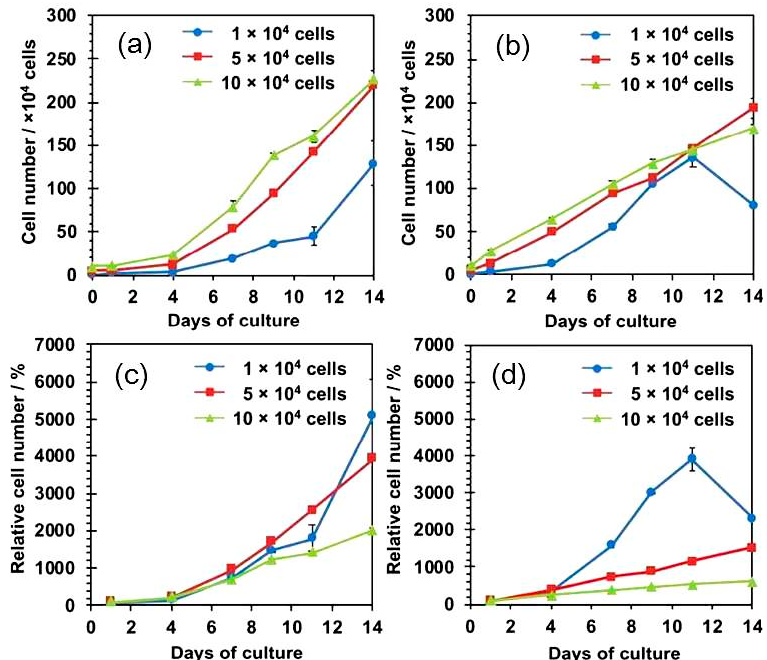
Figure 3. Proliferation profile of human MSCs cultured on three-dimensional (3D) SNFs and tissue culture-treated polystyrene (TCPS) plates with increasing day of culture. ( a , b ) cell number on the SNF ( a ) and TCPS plates ( b ) at di ff erent seeding densities, 1 ( • ), 5 ( (cid:4) ), and 10 ( (cid:78) ) × 10 4 cells / well; ( c , d ) the ratio of cell number to those after 24 h of culture on SNF ( c ) and TCPS plates ( d ) at di ff erent seeding densities, 1 ( • ), 5 ( (cid:4) ), and 10 ( (cid:78) ) × 10 4 cells / well. (S. E., n = 2). ACS Omega, Iijima et al.